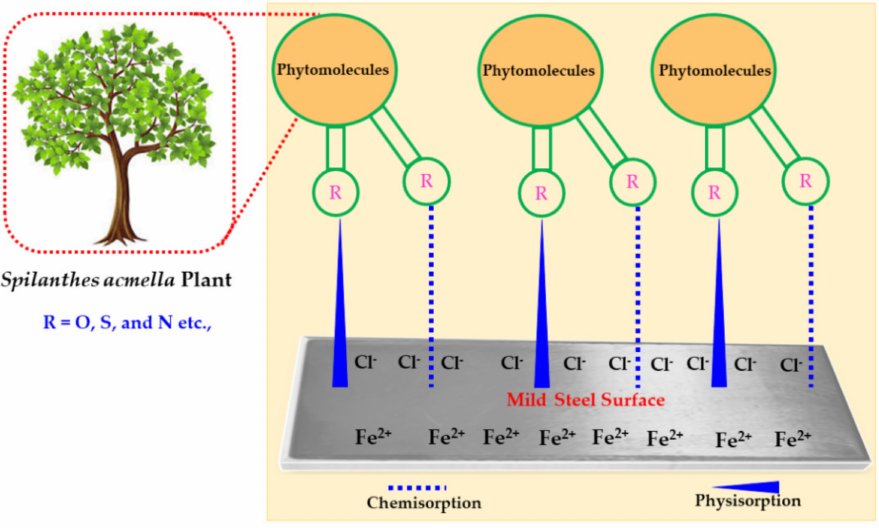
Figure 14. Schematic representation of tentative corrosion inhibition